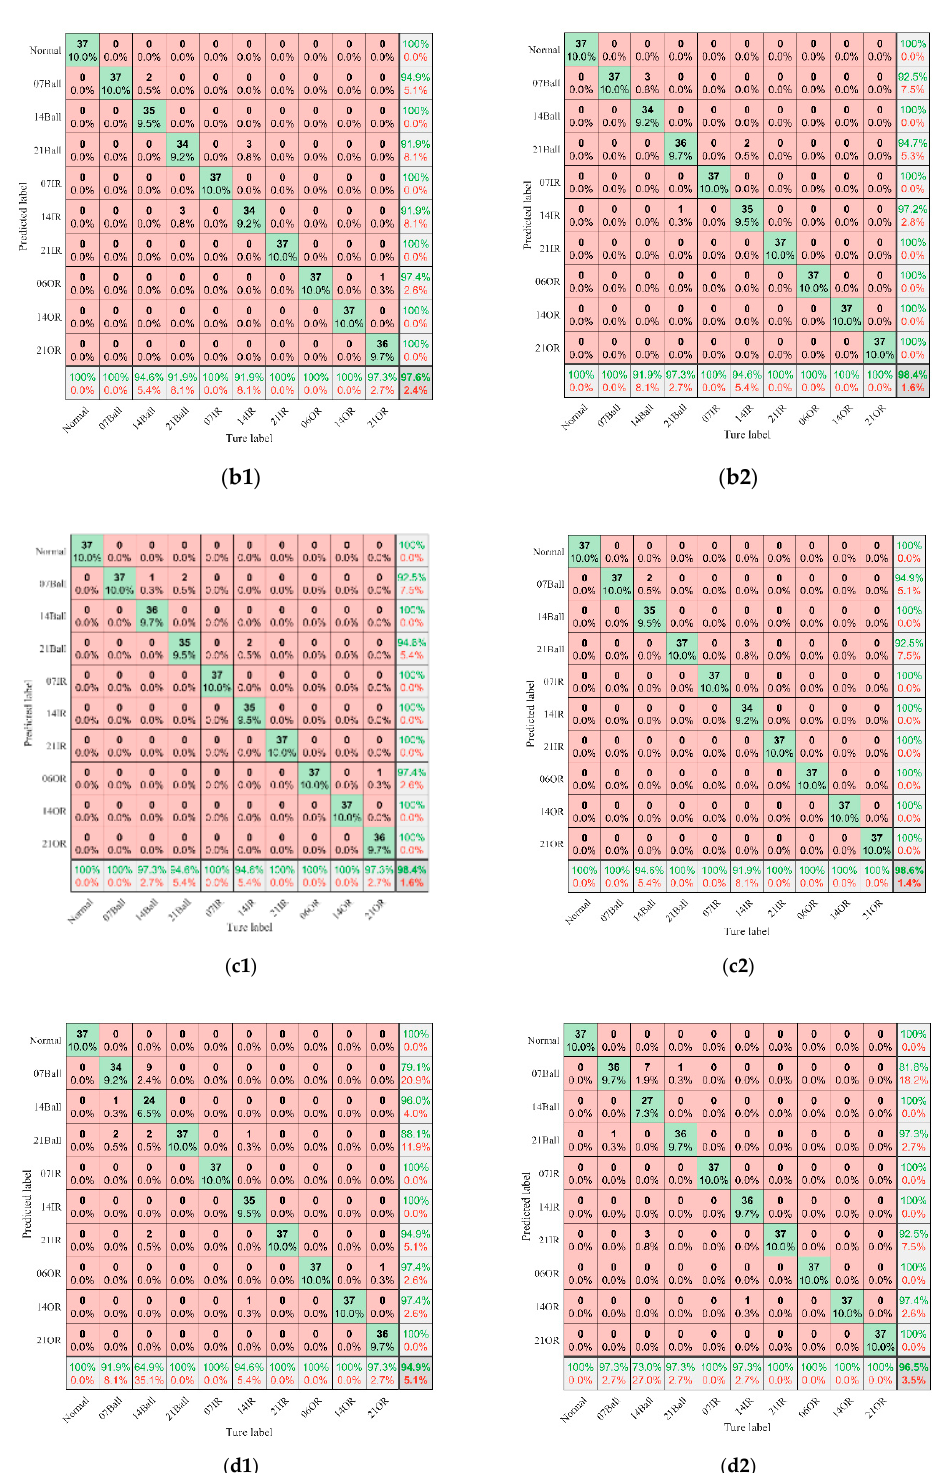
Figure 9. Confusion matrix of the bearing fault classification with CNN and CNNEPDNN. ( a1 )–( d1 ) are the confusion matrix using CNN on dataset A,B,C and D, respectively.( a2 )–( d2 ) are the confusion matrix of CNNEPDNN on dataset A,B,C and D, respectively.